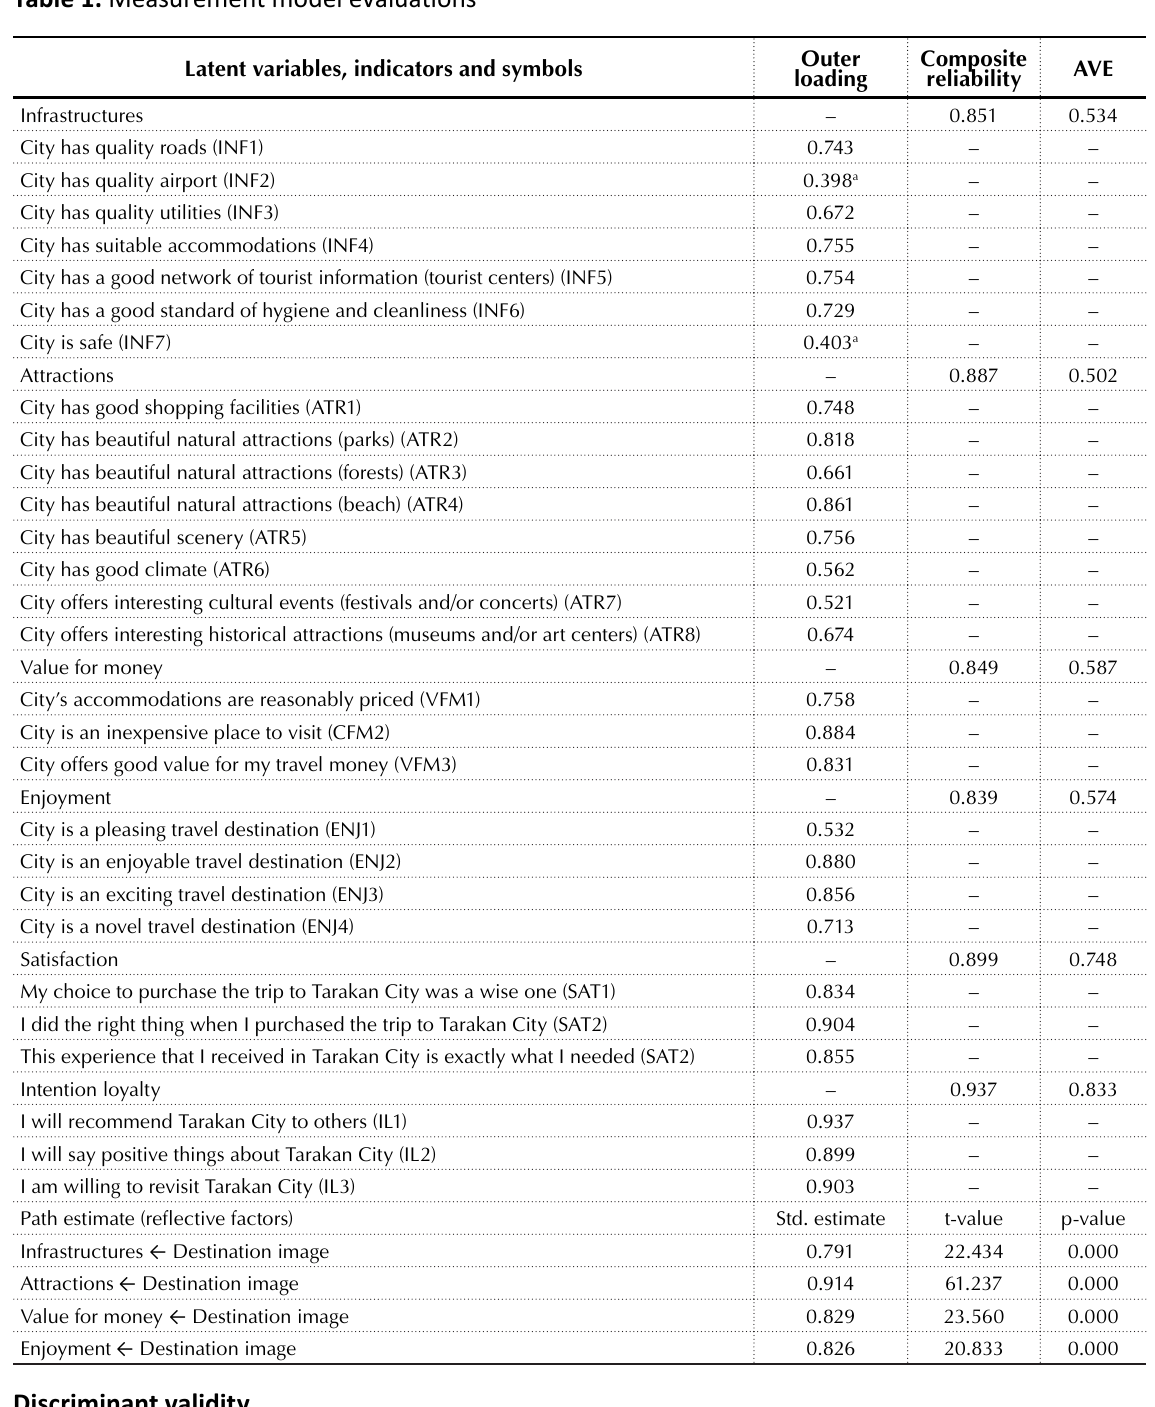
Table 1. Measurement model